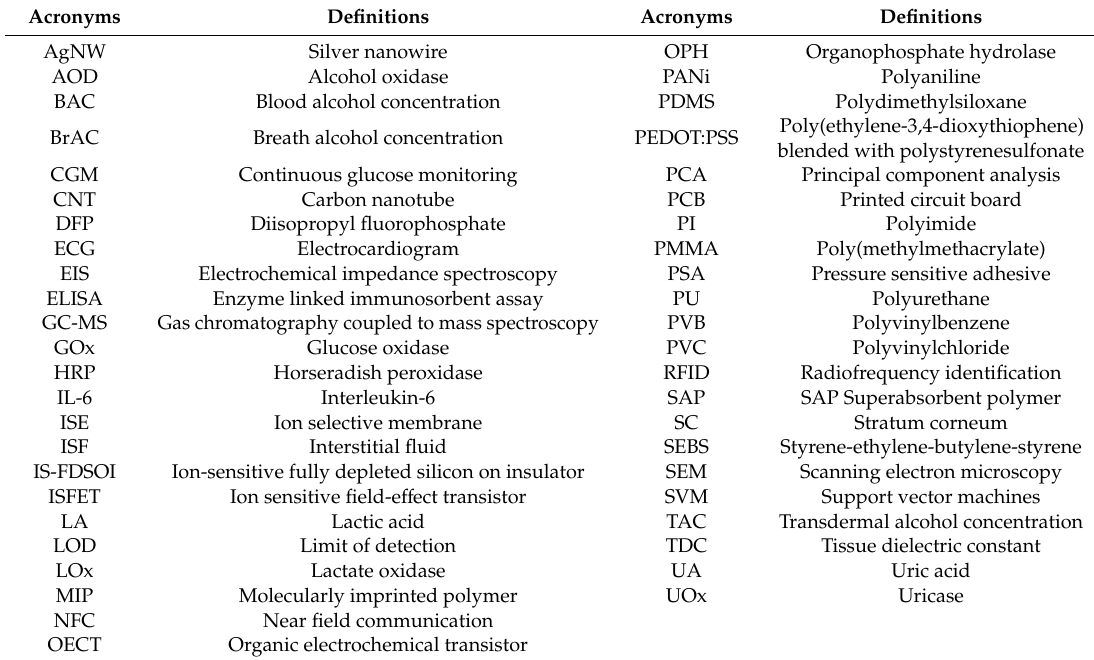
Table 1. Glossary of acronyms used in this